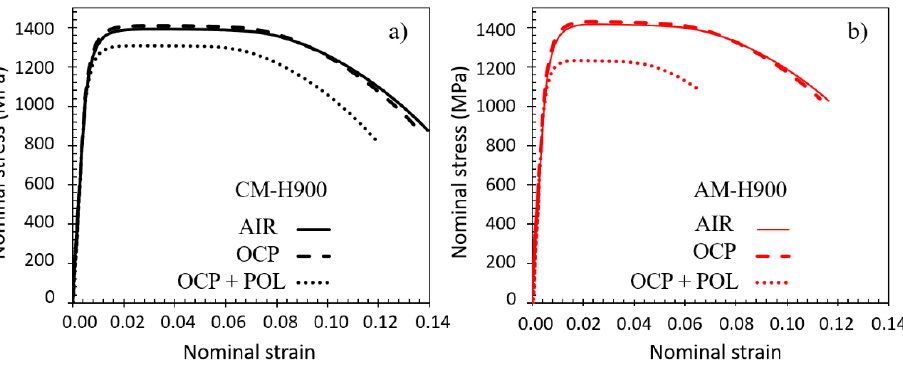
Figure 6. Nominal stress vs. nominal strain curves (10 − 3 s − 1 ) obtained during the EAC tests for ( a ) CM and ( b ) AM samples for two experimental conditions: samples maintained at OCP and tests with a polarisation period (OCP + POL). For both MSSs, curves representative of their mechanical behaviours in air, without any exposure to NaCl solution, were reported (AIR) for comparison. Table 4. Parameters that are characteristic of the mechanical properties and extracted from the tensile curves plotted during the EAC tests (Figure 6). Errors on E, YS 0 . 2 , and UTS are indicated in the table ( ±